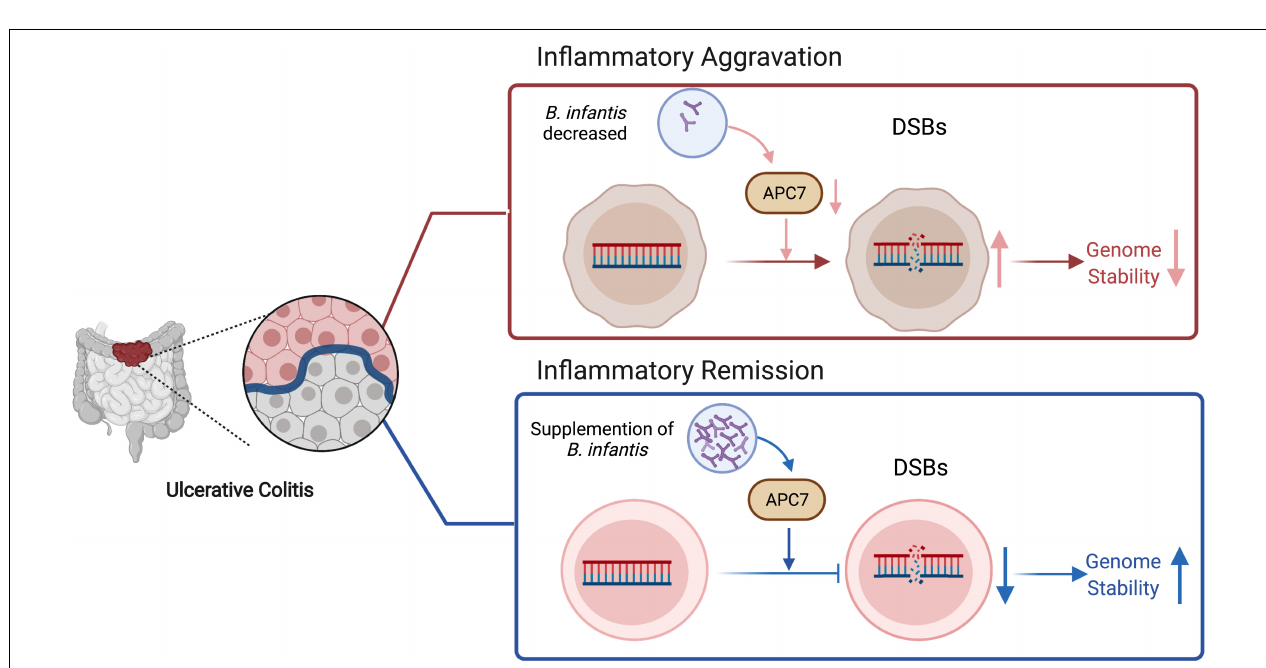
FIGURE 7 | Proposed work model for B. infantis to regulate genome stability through upregulating of APC7 expression in colitis, created with BioRender.com.